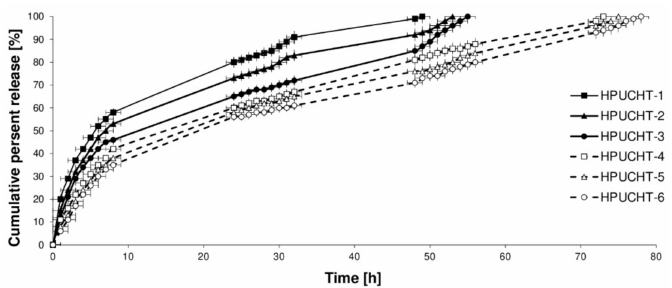
Figure 1. GEN release profiles from the hydrogels.